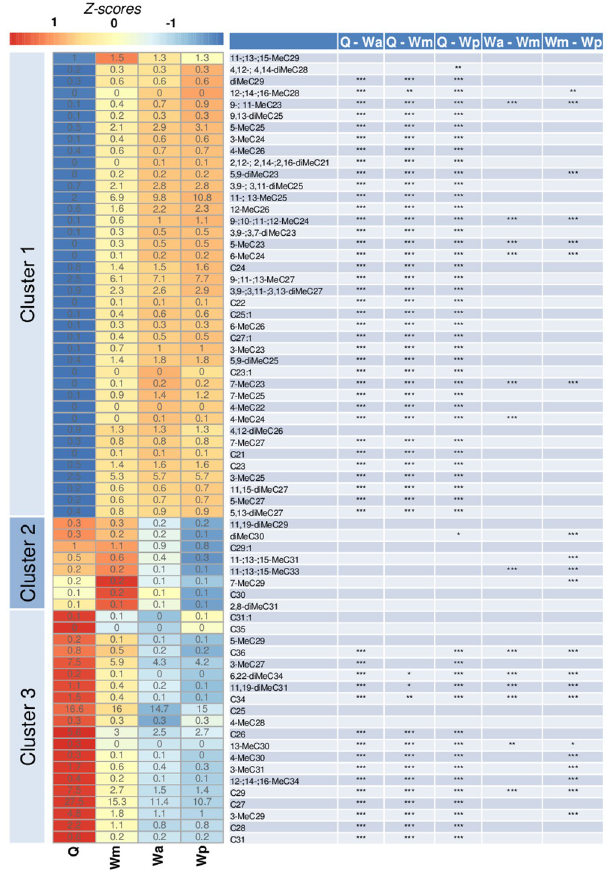
Fig 3. On the left, a heatmap based on the differences in cuticular hydrocarbon profiles on treated individuals, on the right showing all the identified compounds with their significance contrasts based on p-values. Queens are pooled (Q) and different worker treatments (Wm, Wa and Wp) represent methoprene, acetone and precocene, respectively. Contrasts were not significant between Wa-Wp, therefore are not shown. The numbers in the heatmap shows the average relative peak area per compound for each treatment, the background color represents the z-scores. Clusters were obtained by UPGMA clustering and 1-Pearson correlation for the distance matrix. Tukey posthoc contrasts between treatments are obtained from a linear mixed model with Bonferonni correction: � p < 0.05, �� p < 0.01, ��� p <